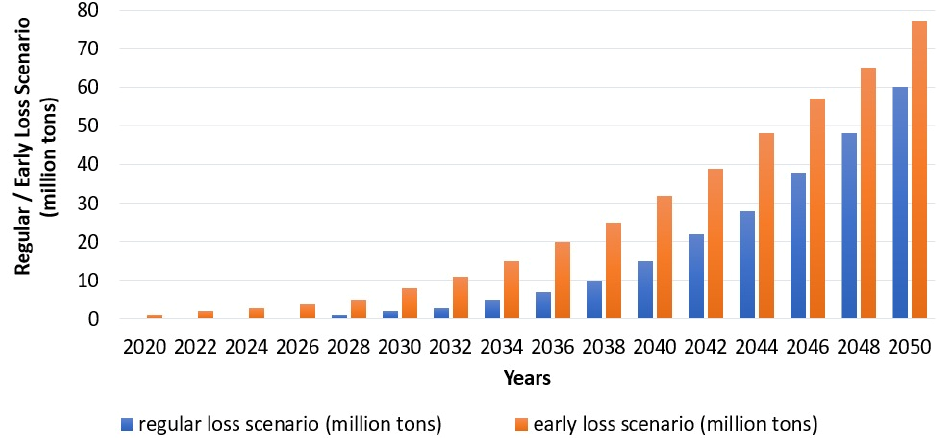
Figure 7. Amount of waste produced by PV panels for 25 or 30 years of average